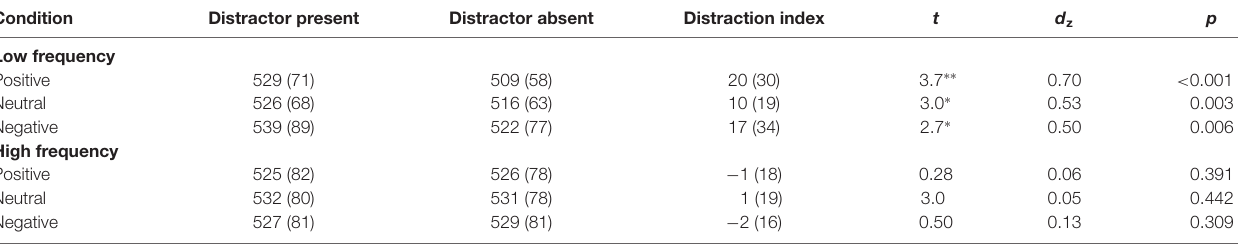
TABLE 1 | Mean (SD) response times and distractor indices (in ms) in each experimental condition.